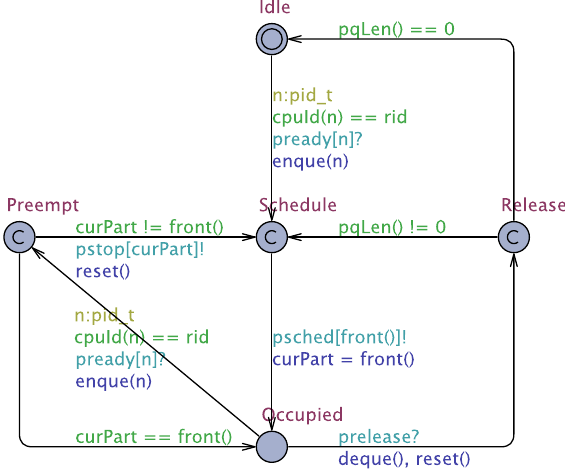
Figure 4. Global scheduler